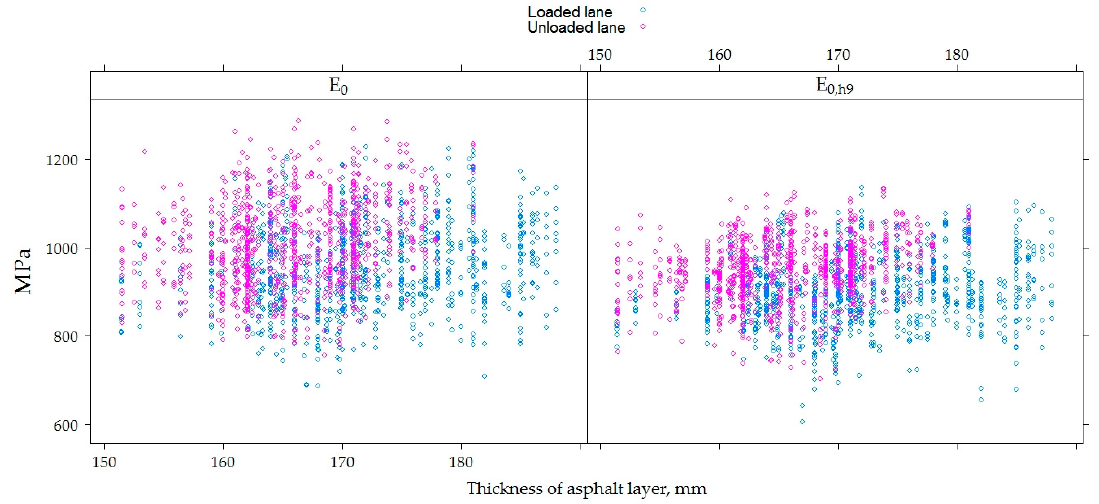
Figure 23. Influence of total thickness of asphalt concrete layers on E 0 and E 0,h9 values in loaded and unloaded lanes.